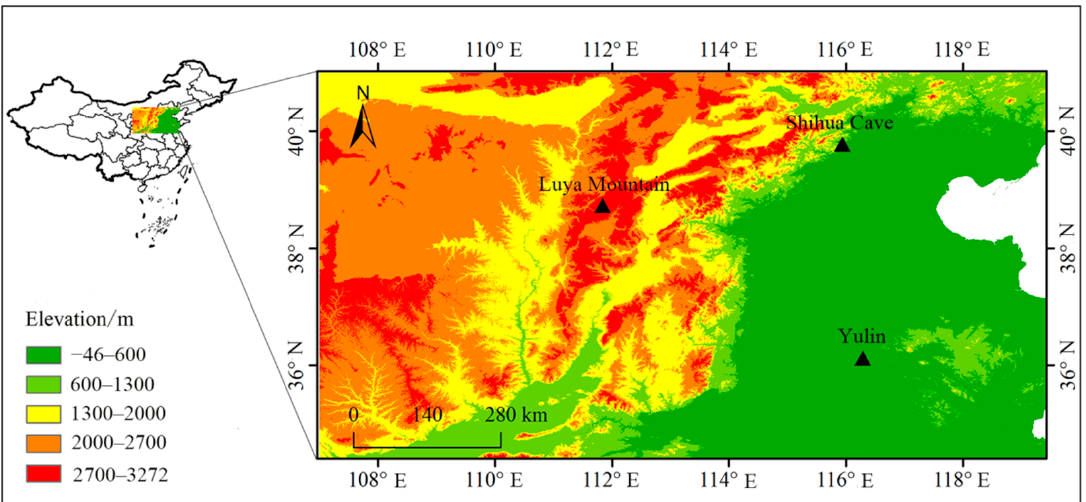
Figure 1. Map showing the study area and sampling sites.